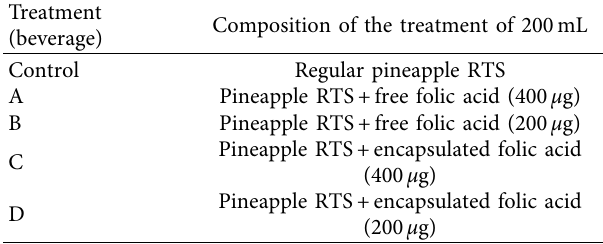
Table 1: Composition of prepared